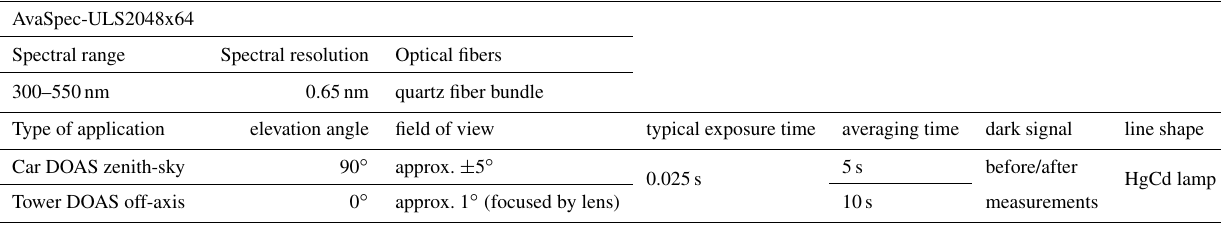
Table 1. Technical characteristics of the DOAS